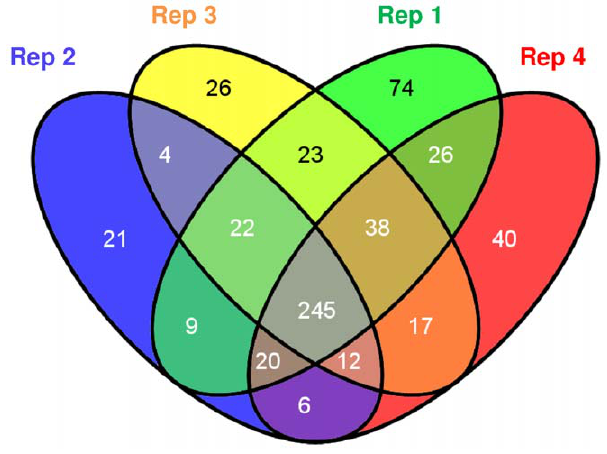
Figure 2. Venn diagram showing the non-redundant proteins quantified in four biological replicates. PLoS ONE |